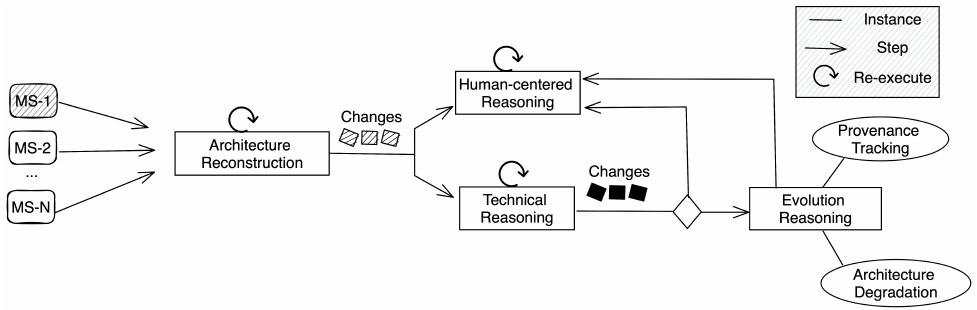
Figure 8. Microservices evolution